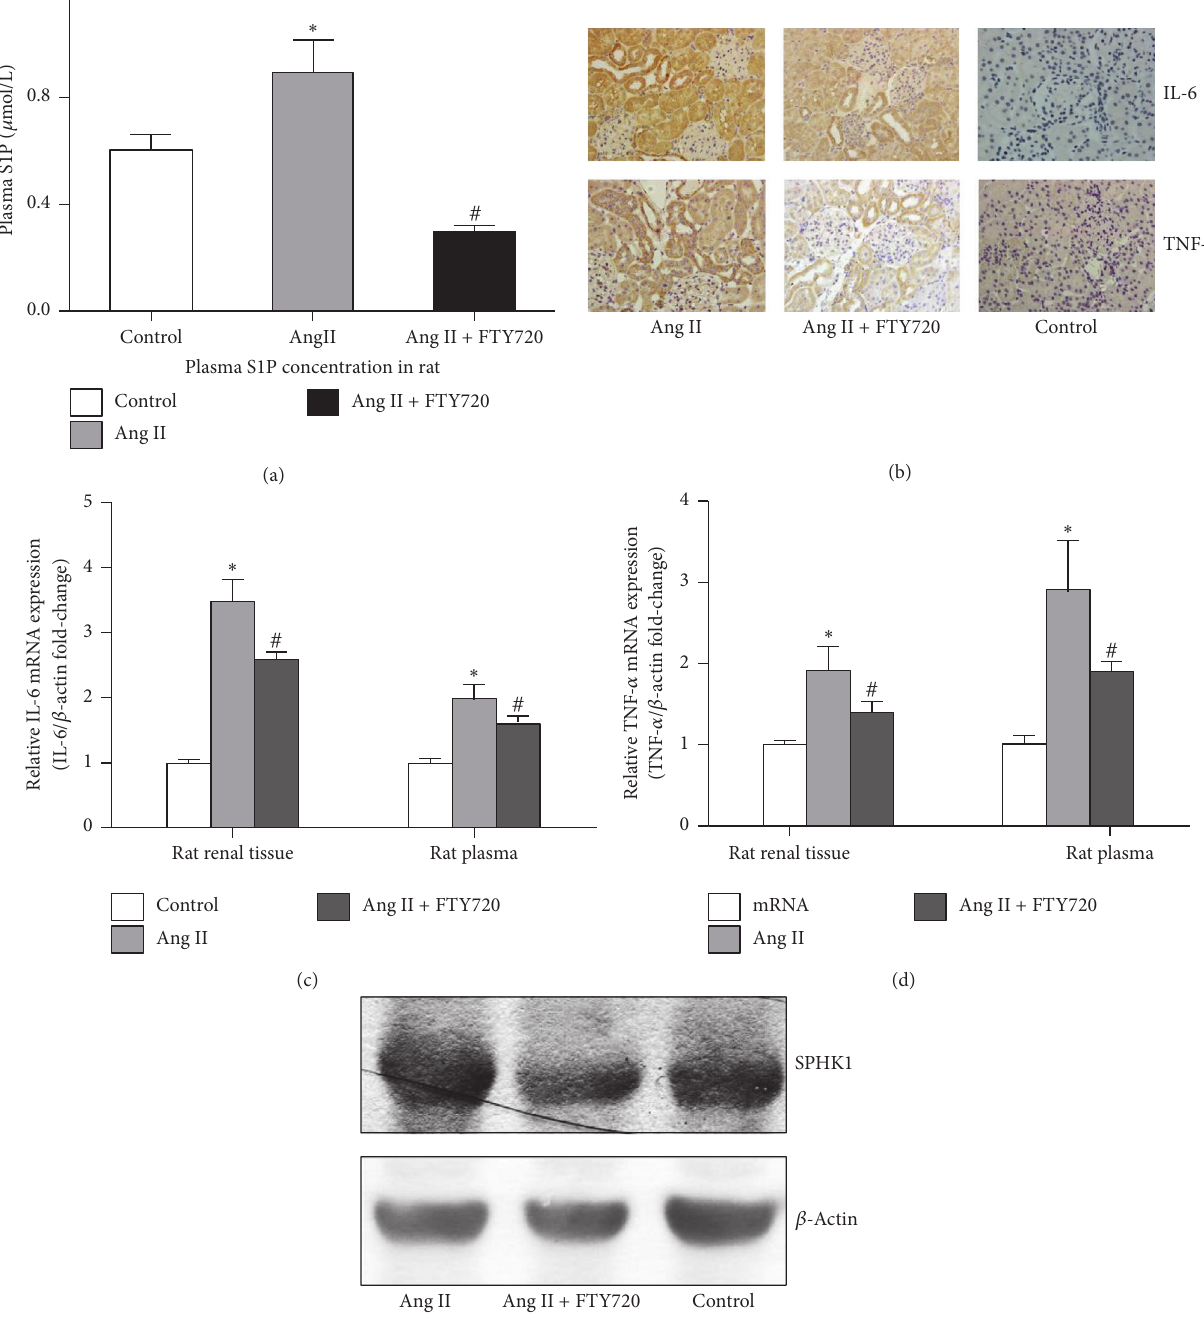
Figure 3: FTY720 decreased S1P synthesis in Ang II-infusion rats via downregulation of inflammatory cytokines. Subcutaneous continuous Ang II-infusion at 400ng/kg ⋅ min concentration in rats for day 28: we sacrificed rats at day 28. FTY720 (0.5 g/kg ⋅ d) was orally administered to rats for 28 days and at the same time rats also received Ang II-infusion. When the mice were sacrificed, the kidney was fixed in paraformaldehyde;immunohistochemicalanalysisofTNF- 𝛼 andIL-6proteinexpressioninkidneysections.Ratbloodsampleswerecollected and plasma was separated for analyzing S1P concentration by ELISA and SPHK1 protein expression level by western blot. Part of the rat kidney tissue homogenate was used to detect IL-6 and TNF- 𝛼 mRNA expression level. Data represented is the means ± SD of 6